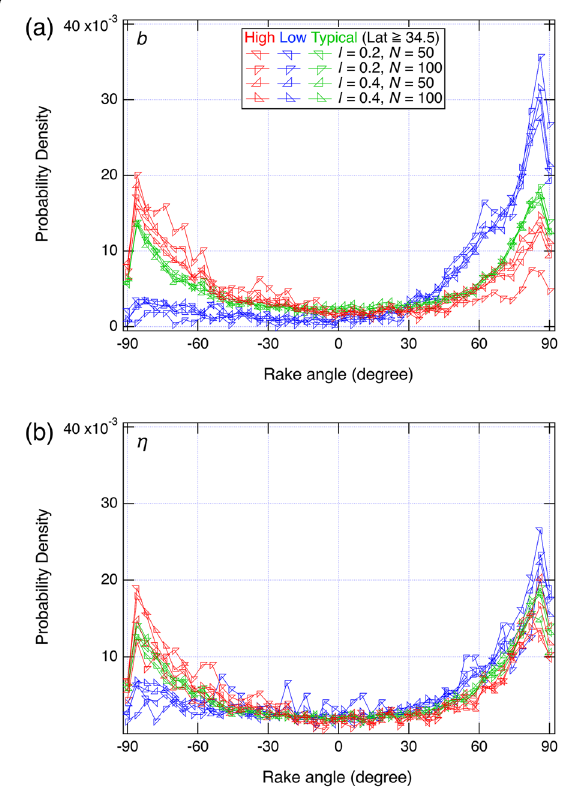
Fig. 11 Probability density distribution of rake angles of earthquakes for a b and b η . Red, blue, and green lines correspond to high, low, and typical values,